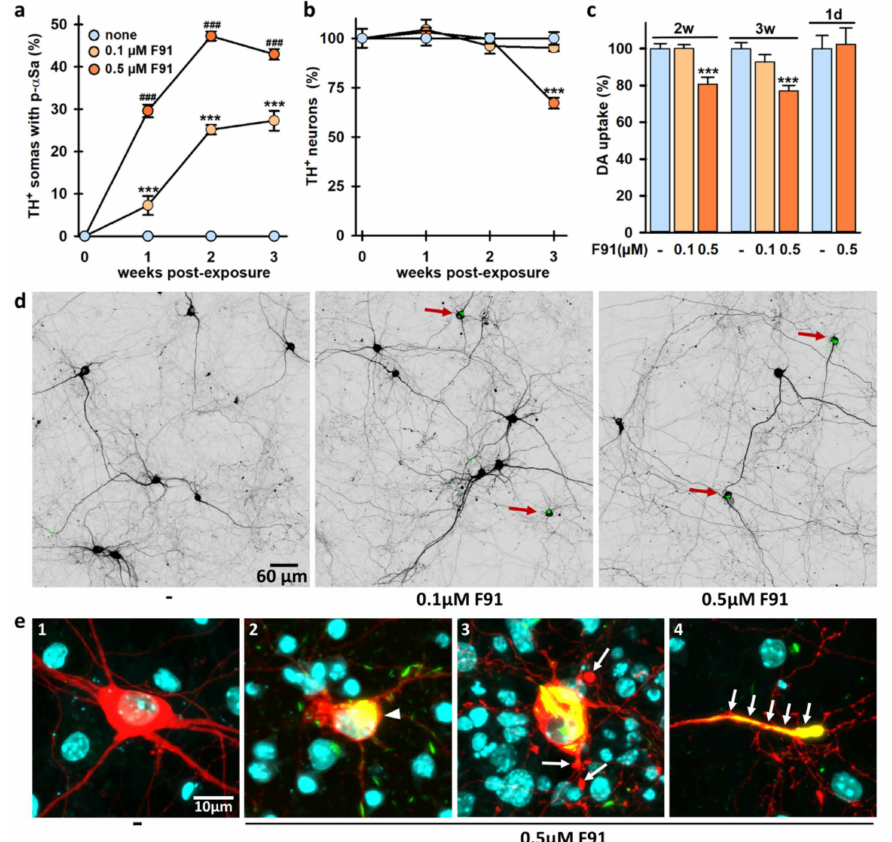
Figure 9. DA cell loss induced by α S seeded aggregation in midbrain cultures. ( a ) Percentage of TH + neurons with somal aggregates in two-week, three-week and four-week midbrain cultures exposed one, two and three weeks earlier, respectively to 0.1 or 0.5 µ M F91. Data are means ± SEM (4–9). *** p < 0.001, vs. controls and ### p < 0.001 vs. 0.1 µ M F91. One-way ANOVA followed by SNK test. ( b ) Survival of TH + neurons in midbrain cultures exposed to same treatments as in ( a ). Data are means ± SEM (4–9). *** p < 0.001, vs. controls. One-way ANOVA followed by Dunnett’s test. ( c ) Tritiated-DA uptake in three-week and four-week midbrain cultures exposed two weeks and three weeks earlier, respectively, to 0.1 and 0.5 µ M F91. Some of the three-week cultures were treated with 0.5 µ M F91 only one day before being assayed for DA uptake. Data are means ± SEM (8–14). *** p < 0.001, vs. controls. One-way ANOVA followed by Dunnett’s test. ( d ) Representative low-magnification microphotographs showing TH + neurons in four-week midbrain cultures exposed or not exposed three weeks earlier to 0.1 µ M or 0.5 µ M F91. α S inclusions (green) in TH + soma are pointed out by red arrows. ( e ) Confocal images describing morphological changes affecting TH + neurons in four-week midbrain cultures exposed three weeks before to 0.5 µ M F91. ( 1 ) TH + (red) neuron with an intact morphology in a control culture. ( 2 ) Cell body shrinkage (white arrowhead) of a TH + neuron showing a large, rounded inclusion (yellow after merging green and red). ( 3 ) Blebs (white arrows) onto proximal neurites of a TH + neuron with a large somal α S inclusion. ( 4 ) Distal TH + neuritic extension packed with p- α S material (white arrows). Nuclei are counterstained with Hoechst-33342